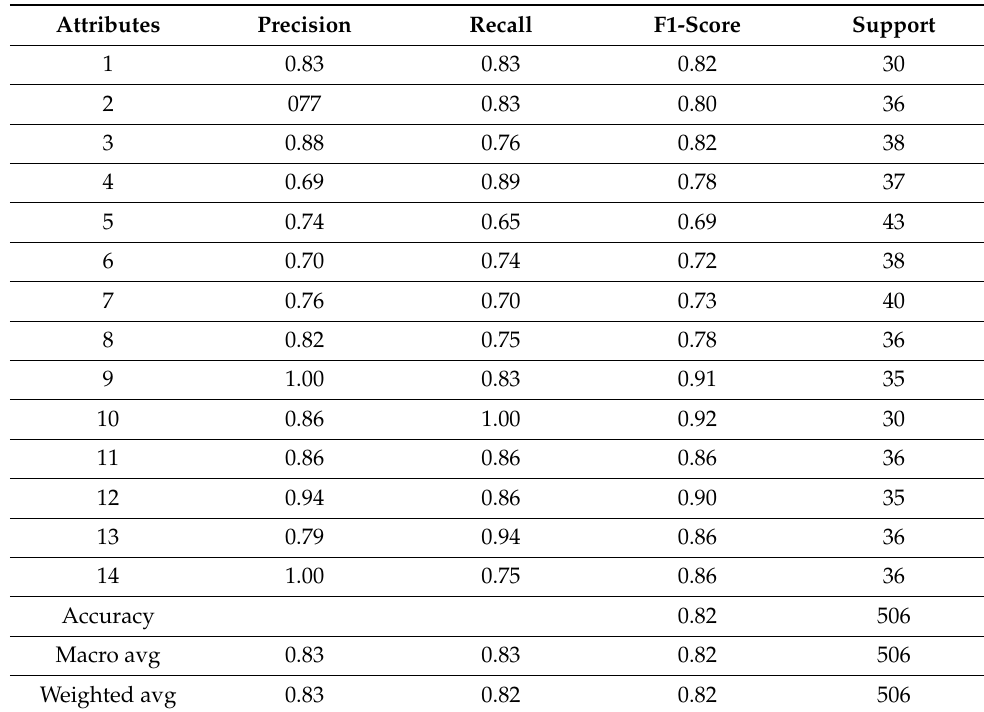
Table 3. Confusion matrix and classification report for the training